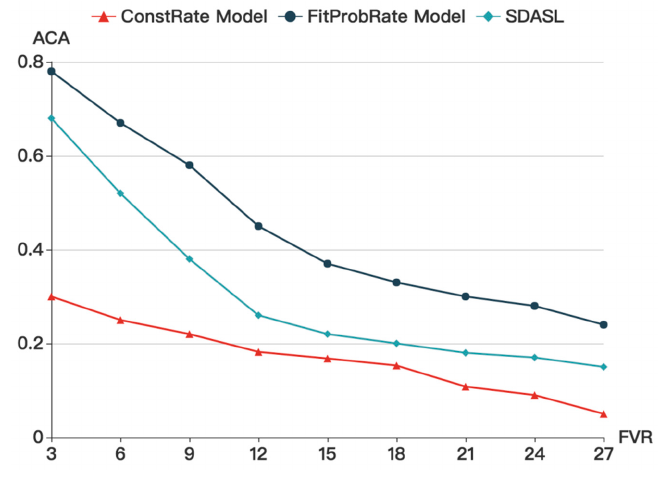
Figure 9. Comparison of ACA.